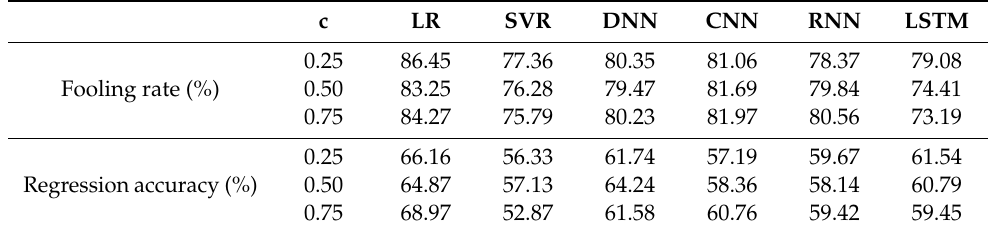
Table 6. Performance comparison of data-driven models by adversarial retraining.